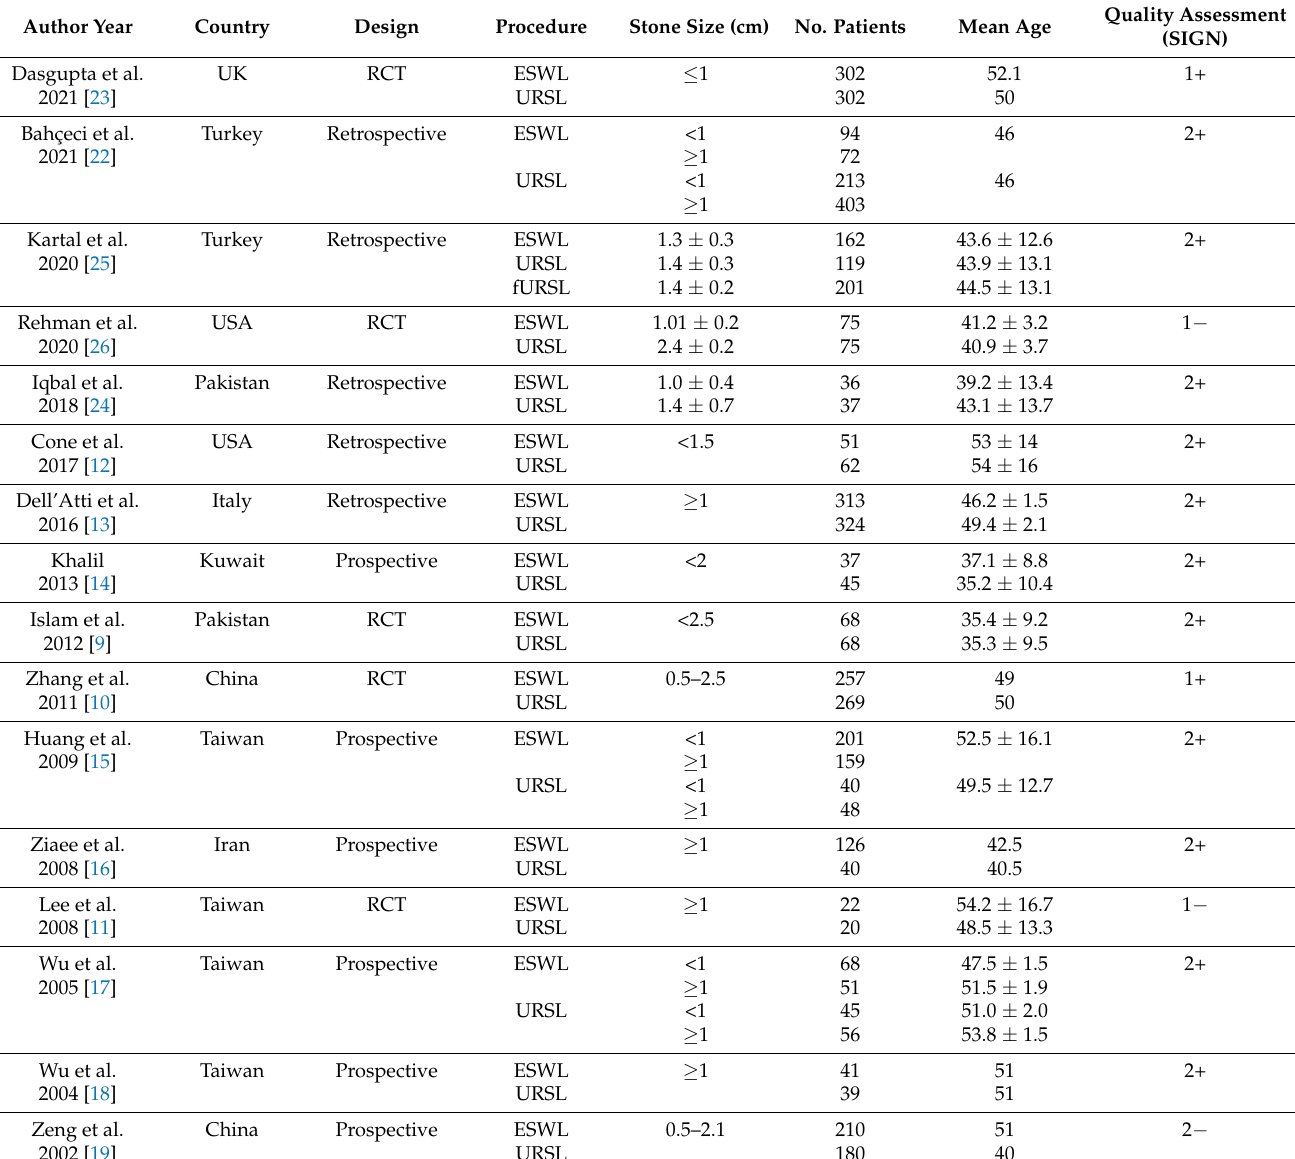
Table 1. Characteristics of included